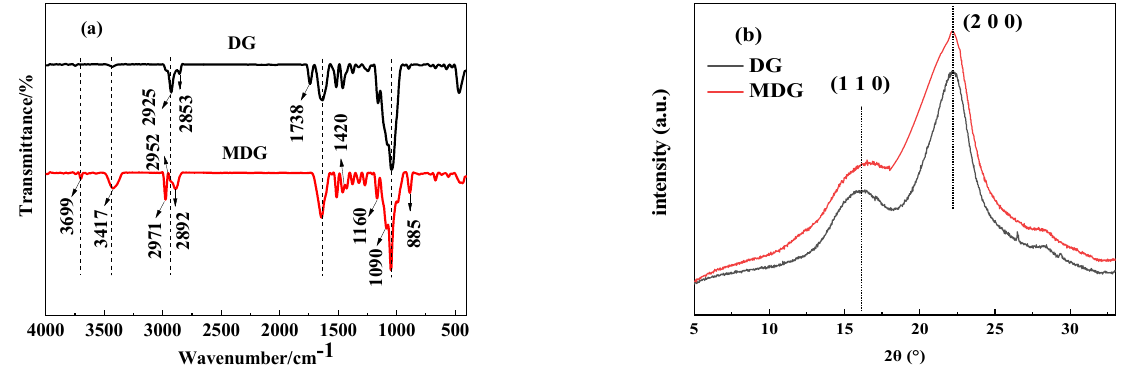
Figure 5. ( a ) FTIR spectra of DG and MDG ( b ) XRD patterns of DG and MDG.